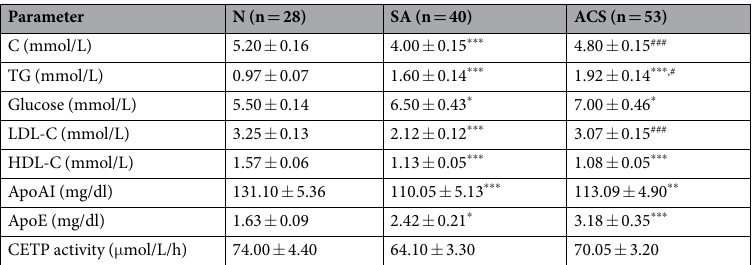
Table 2. Plasma biochemical data from CAD patients and healthy subjects. N - healthy subjects, SA - stable angina patients, and ACS - acute coronary syndrome patients; n - number of subjects, C - total cholesterol, TG - triglycerides, LDL-C – low-density lipoproteins cholesterol, HDL-C – high-density lipoproteins cholesterol, ApoAI - apolipoprotein AI, ApoE –apolipoprotein E; CETP - cholesteryl esters transfer protein. Data are expressed as means ± SEM and analyzed with two-tailed Oneway ANOVA with Least Significant Difference (LSD) Post-hoc test. * p < 0.05, ** p < 0.01, *** p < 0.001 vs. N; # p < 0.05, ### p < 0.001 vs.